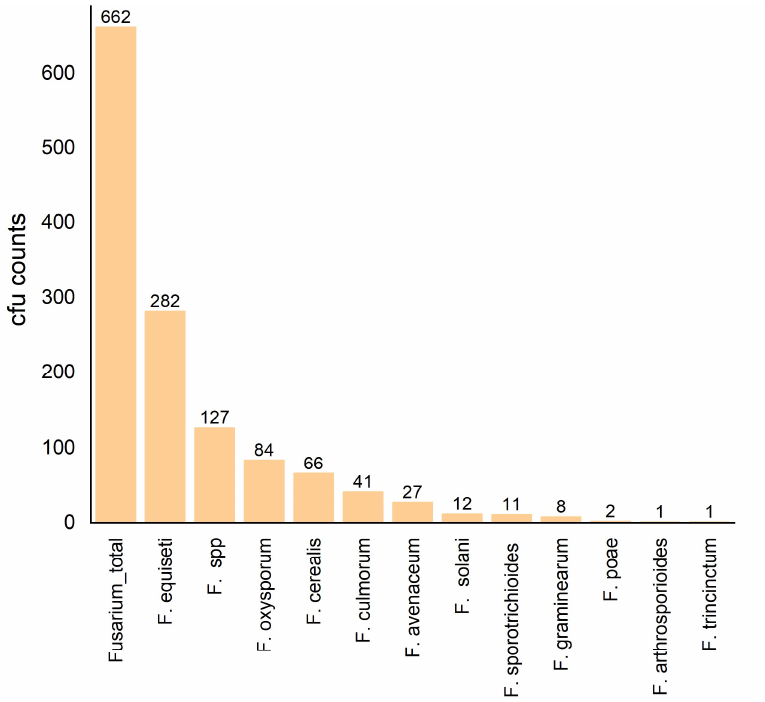
Figure 4. Identified Fusarium cfu on species level across all measurements (controls and actual dispersal measurements) regardless of wind tunnel treatment (wtt). The bars show the related Fusarium species counted on the three trap plates of the Air Sampler Box (ASB) across all runs. Data were collected over a month and reflected a total of 90 runs.